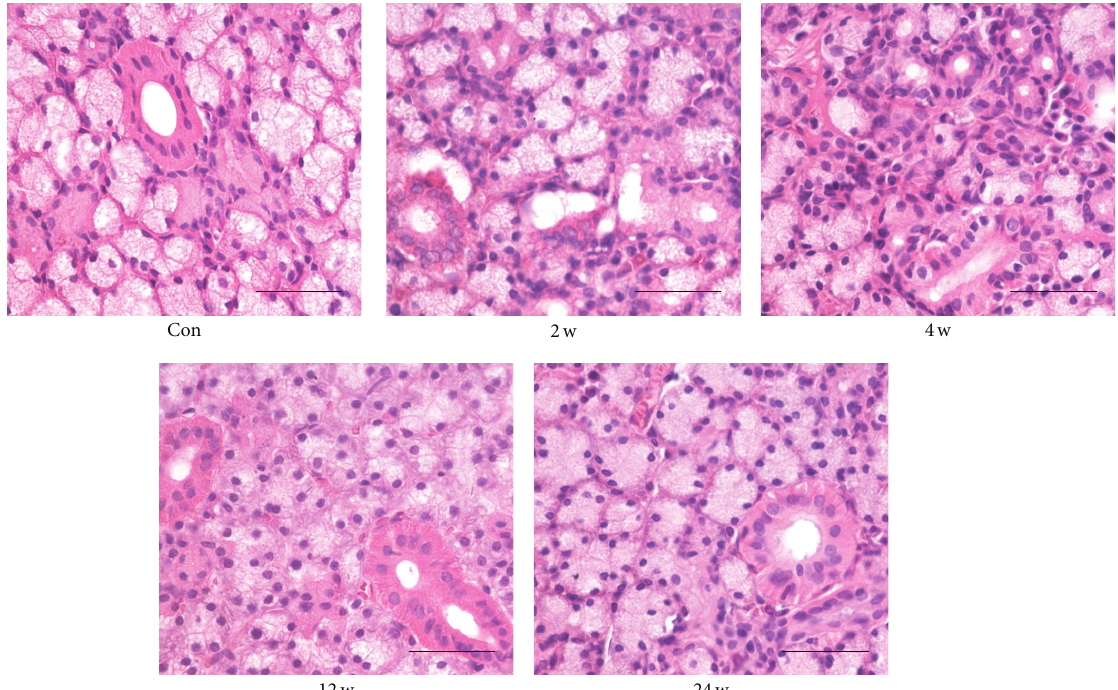
Figure 3: HE-stained sections for the structural changes of the transferred submandibular glands after BTXA injection on control group and 2, 4, 12, and 24 weeks groups (scale bar, 50 𝜇